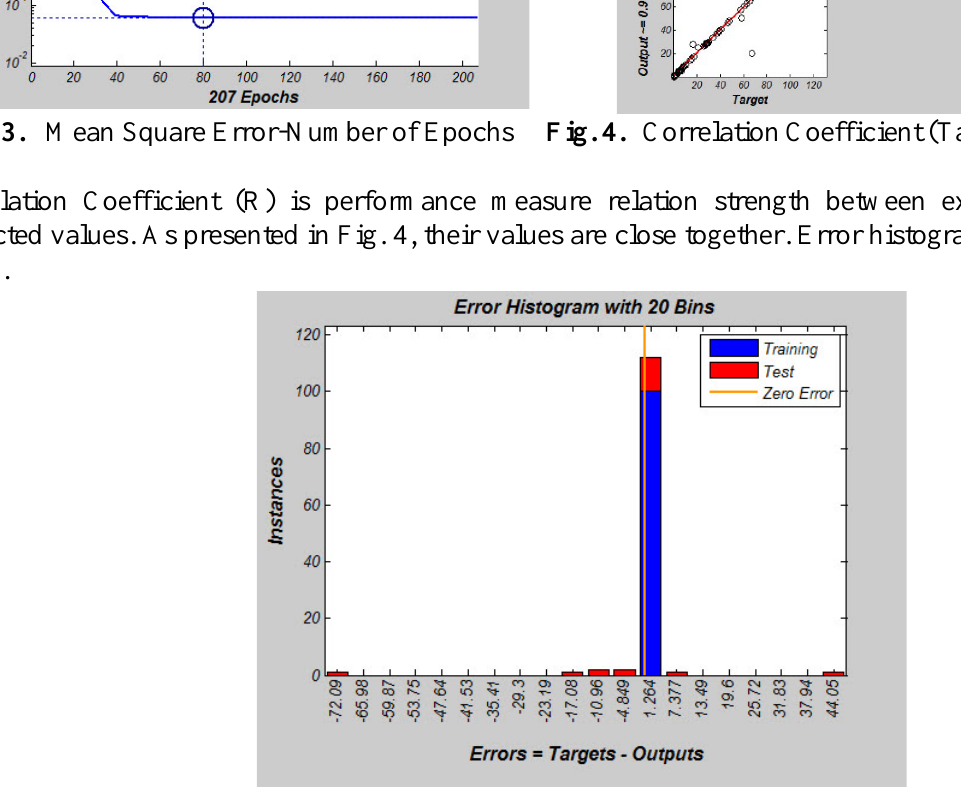
Fig. 5. Error Histogram results